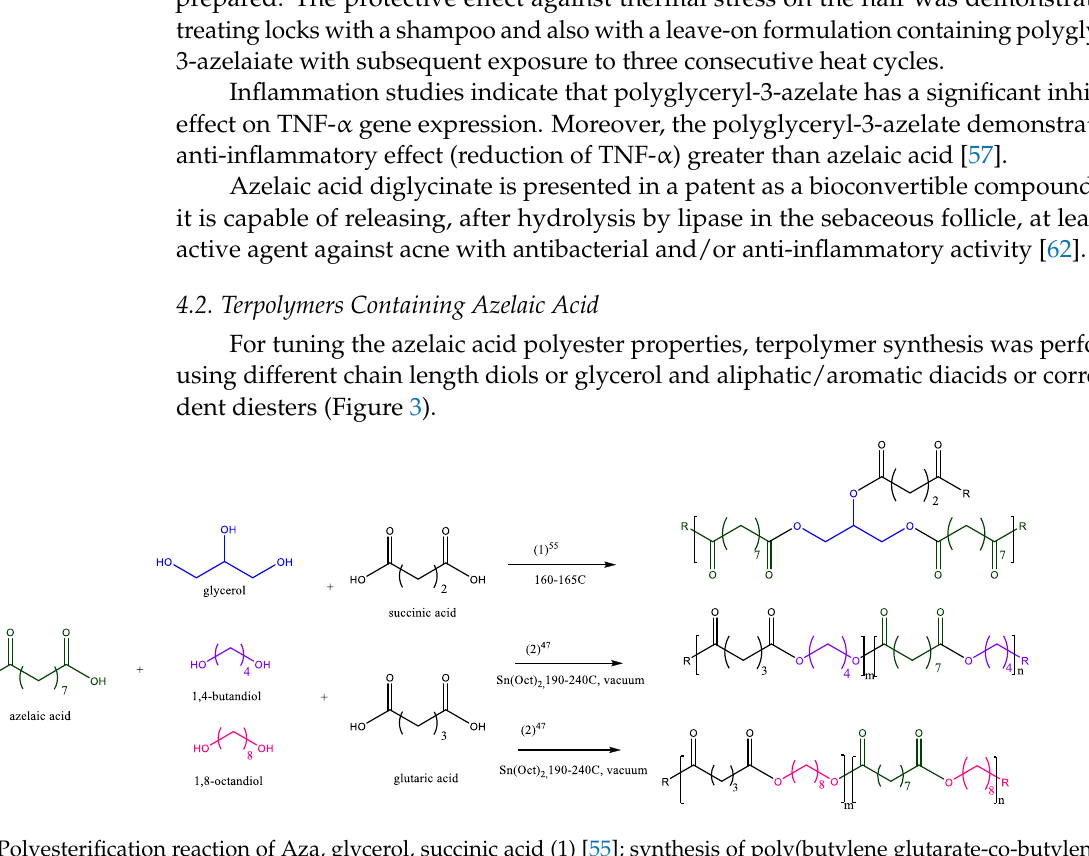
Figure 3. Polyesterification reaction of Aza, glycerol, succinic acid (1) [55]; synthesis of poly(butylene glutarate-co-butylene azelate) and poly(octylene glutarate-co-octylene azelate) copolyesters in two steps (2) [47].